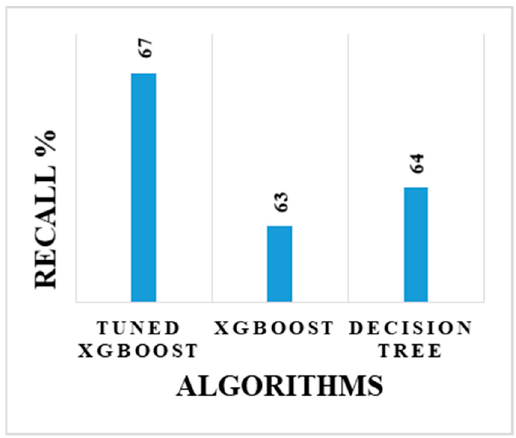
Figure 3. Comparison of recall results.